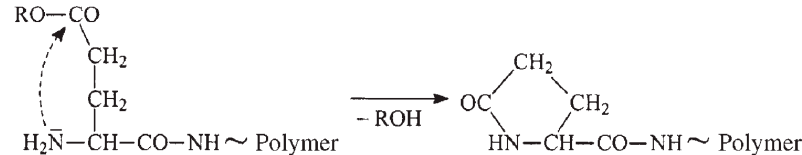
Figure 9. Intramolecular termination step that is typical for poly( γ - O -allyl- L -glutamate)s. Reproduced with permission from reference [58].